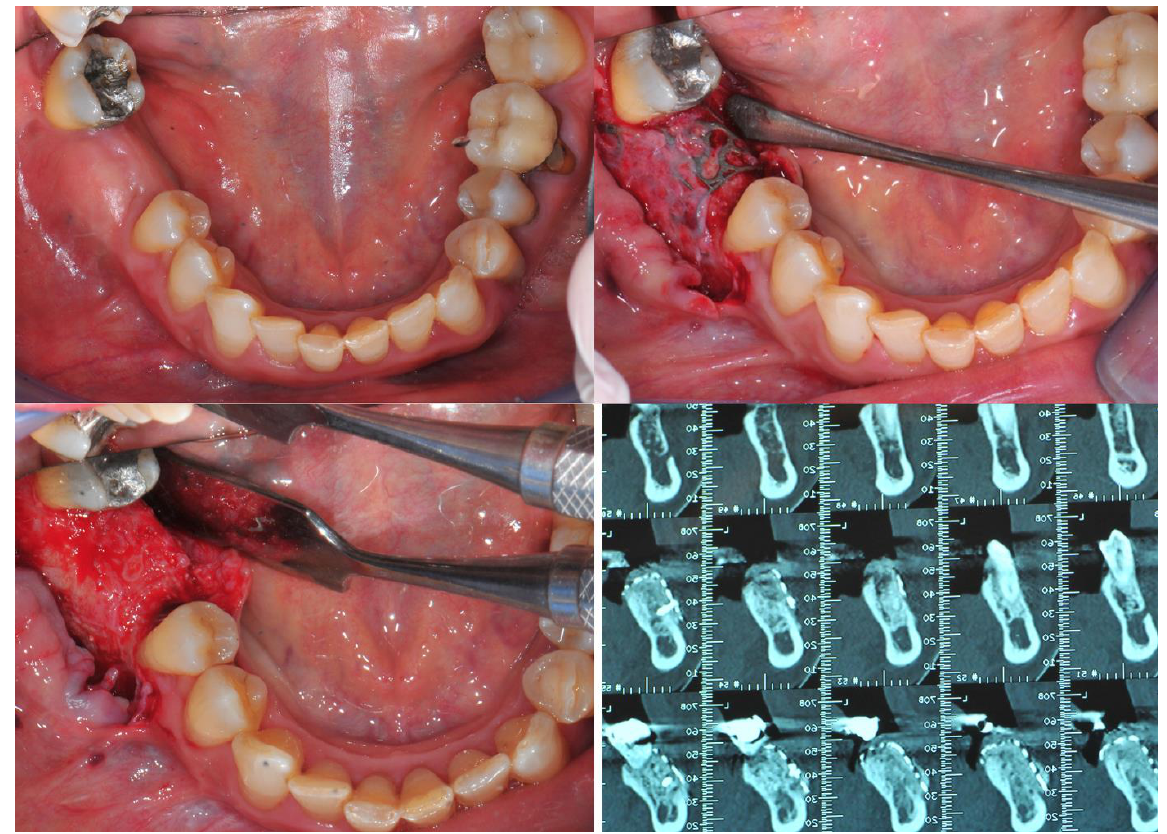
Figure 4. This composite resumes the surgical workflow from the custom Ti Mesh graft healing to the implant placement. In the CBCT (T1) screenshots it is possible to appreciate the bone volume gain. From the top left clockwise: starting situation, grid removal after 6 months; section of CBCT shows the bone volume gain, occlusal view just before implant surgery.